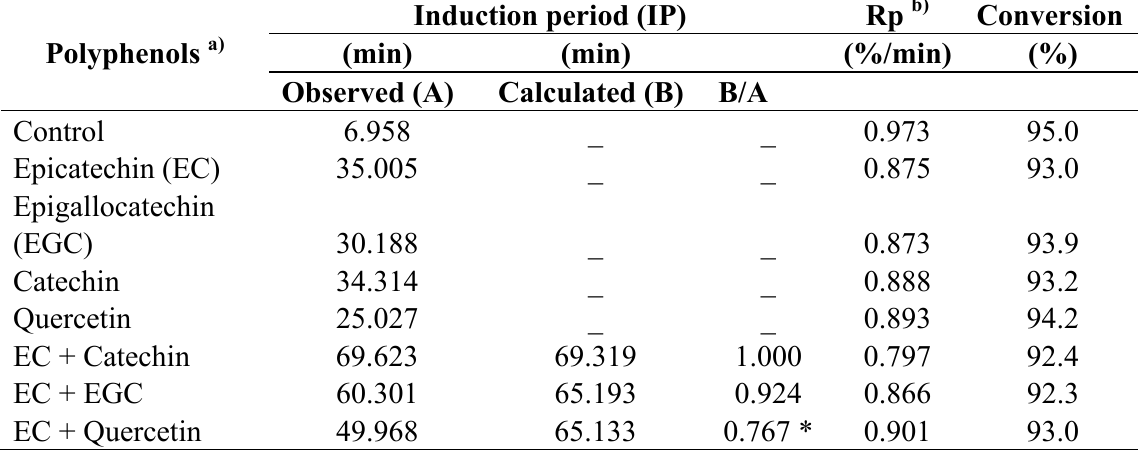
Table 2. Radical-scavenging activity for 2-polyphenols